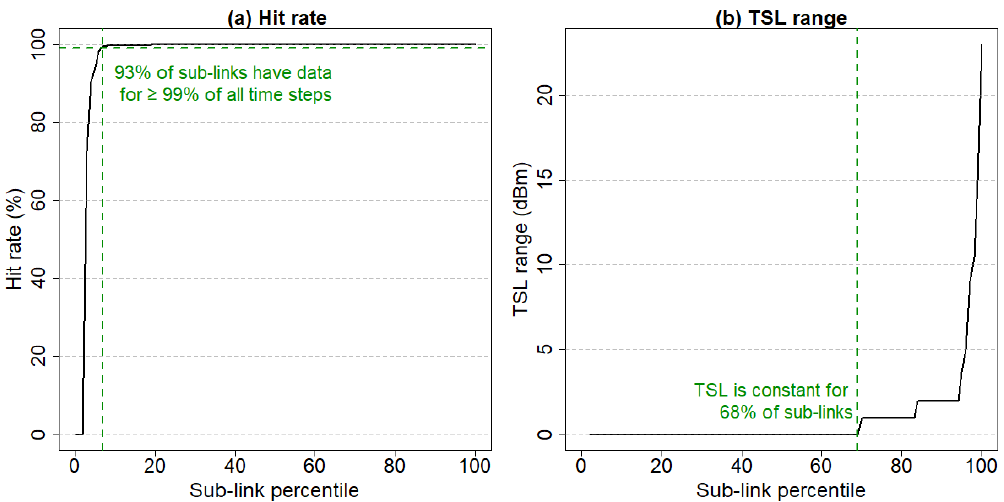
Figure 6. CML data collection performance. (a) Distribution of the data collection hit rate (percent of time steps with valid RSL and TSL measurements) across all sub-links. In total, 93% of sub-links have both RSL and TSL data for ≥ 99% of all time steps in the sampling period. (b) Stability of the transmitted signal level (TSL) across all sub-links. TSL does not vary at all for a majority of the sub-links